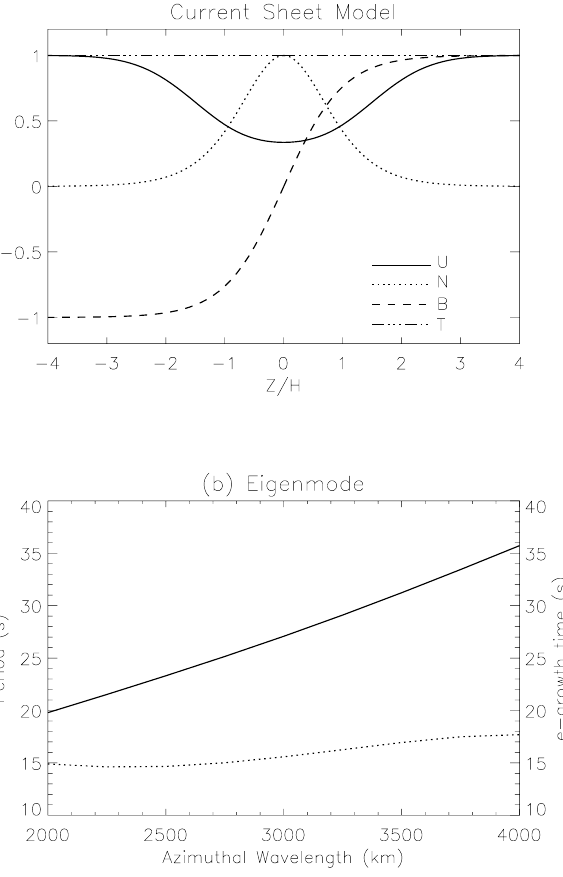
Fig. 3. Same as Fig. 2, but for the variable temperature model given in Eq. (39). The quasi-electrostatic field is absent in this